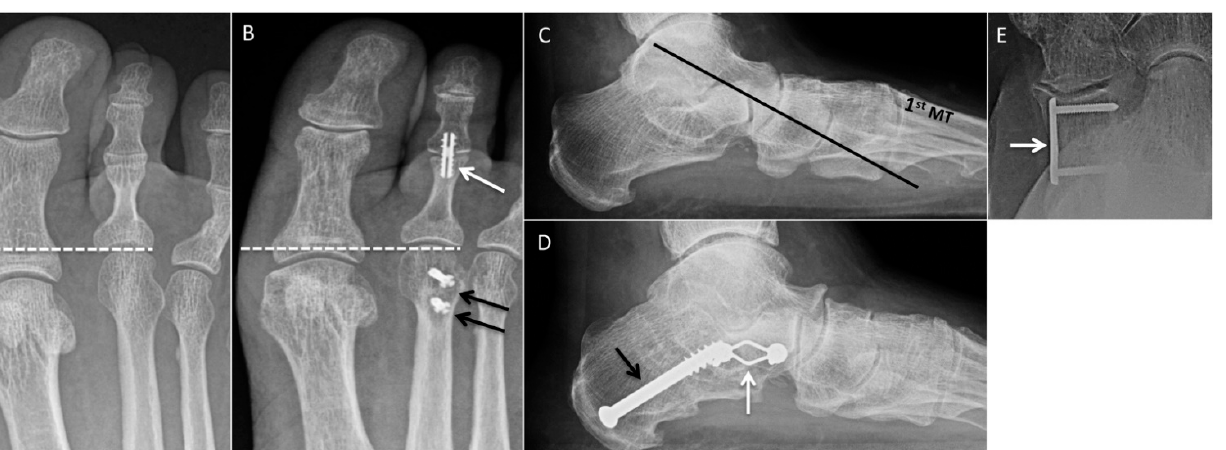
Figure 4. Osteotomies. ( A ) Preoperative AP radiograph demonstrating long-second metatarsal in a patient with plantar pain. ( B ) Postoperative radiograph showing findings of Weil osteotomy with screw fixation (black arrows) with decreased length of the second metatarsal (white dashed lines). Additionally, the patient underwent second PIP arthrodesis (white arrow). ( C ) Preoperative lateral radiograph demonstrating altered tarsometatarsal axis (black line) passing plantar to the first metatarsal. Postoperative lateral ( D ) and AP ( E ) radiographs demonstrating healed medializing calcaneal osteotomy (black arrow) and Evans lengthening osteotomy (white arrows).